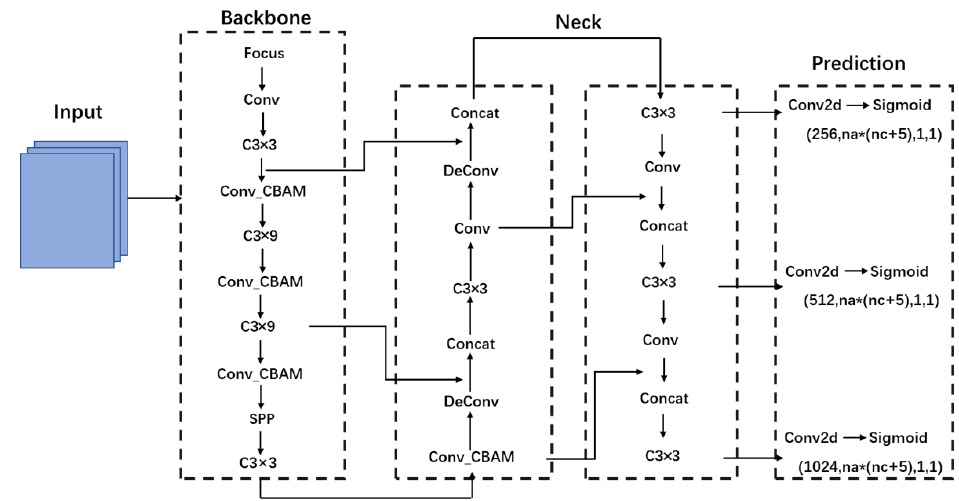
Figure 5. The network structure of YOLOv5-CBAM + TC.